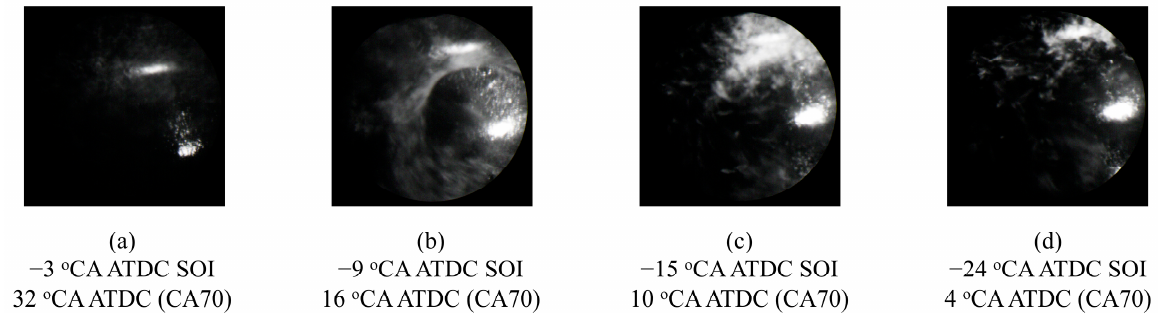
Figure 9. Comparative flame images at CA70 and 59% EGR over the range of SOI’s tested; ( a )—3 °CA ATDC ( b )—9 °CA ATDC ( c )—15 °CA ATDC ( d )—24 °CA ATDC SOIs. The intensity of the images is increased by a factor of two.